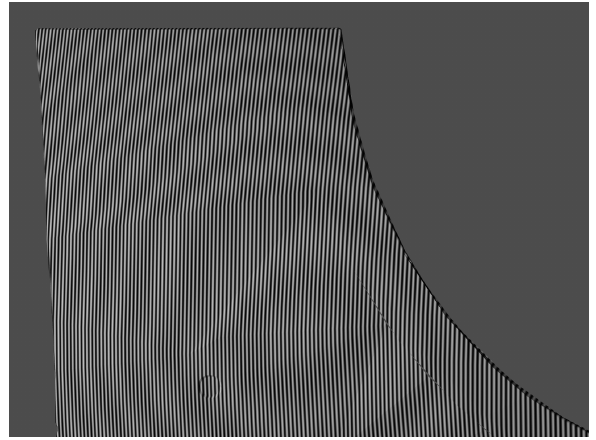
Figure 6. Render result with gray code (7th-Bit)